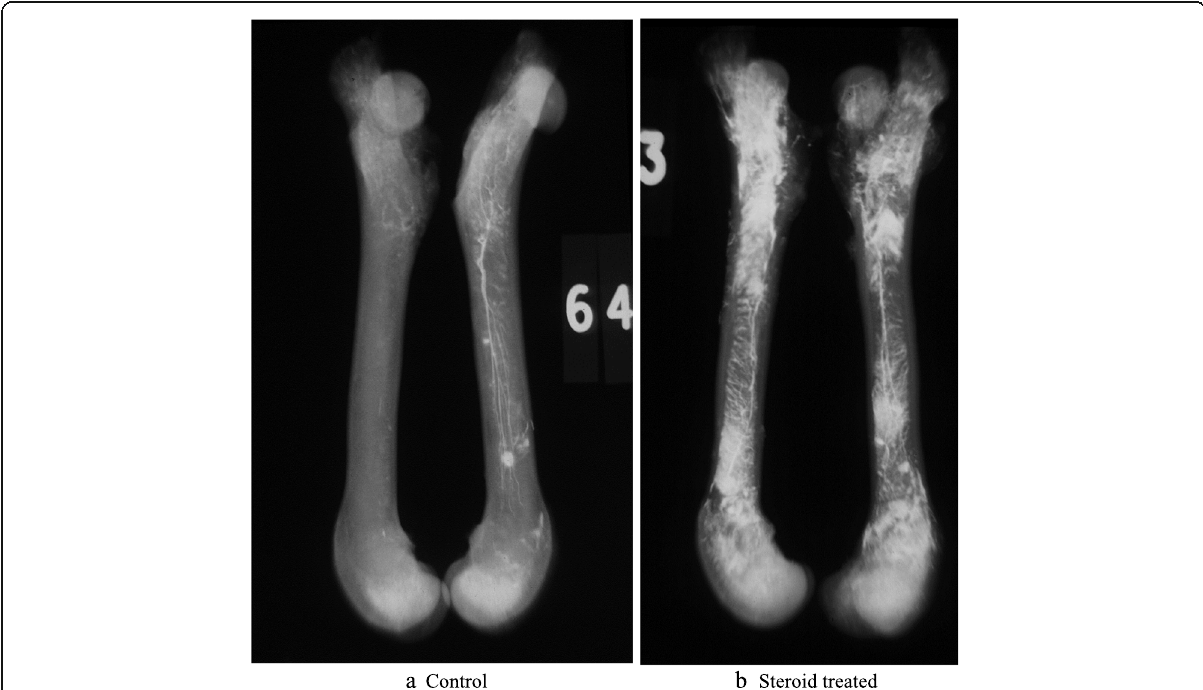
Fig. 5 a and b showing examples of femoral angiogram microradiographs. The left radiograph 5a shows a pair of femora from a control barium angiogram. The right femoral pair 5b were from a steroid treated subject. After steroid treatment there was better barium